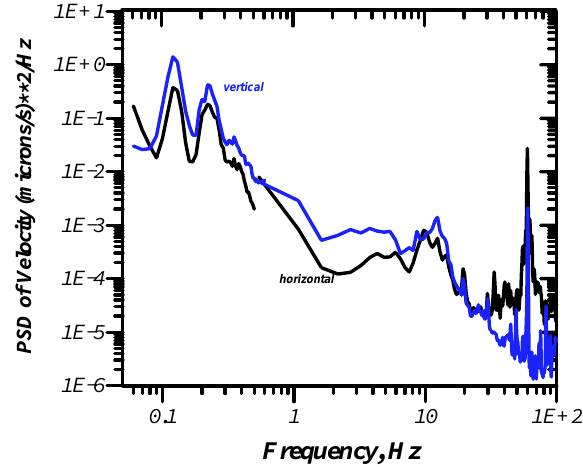
FIG. 15. (Color) Comparison of vertical and horizontal ground motion spectra. TARP measurements.